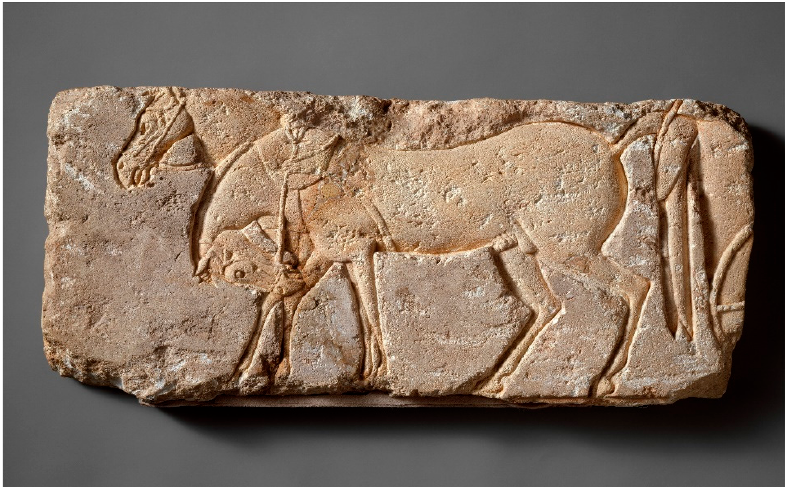
Figure 19. Two stallions in front of a chariot on a talatat from Amarna. Metropolitan Museum of Art. Gift of Norbert Schimmel, Inv. no. 1985.328.18. Amarna period (end 18th dynasty).